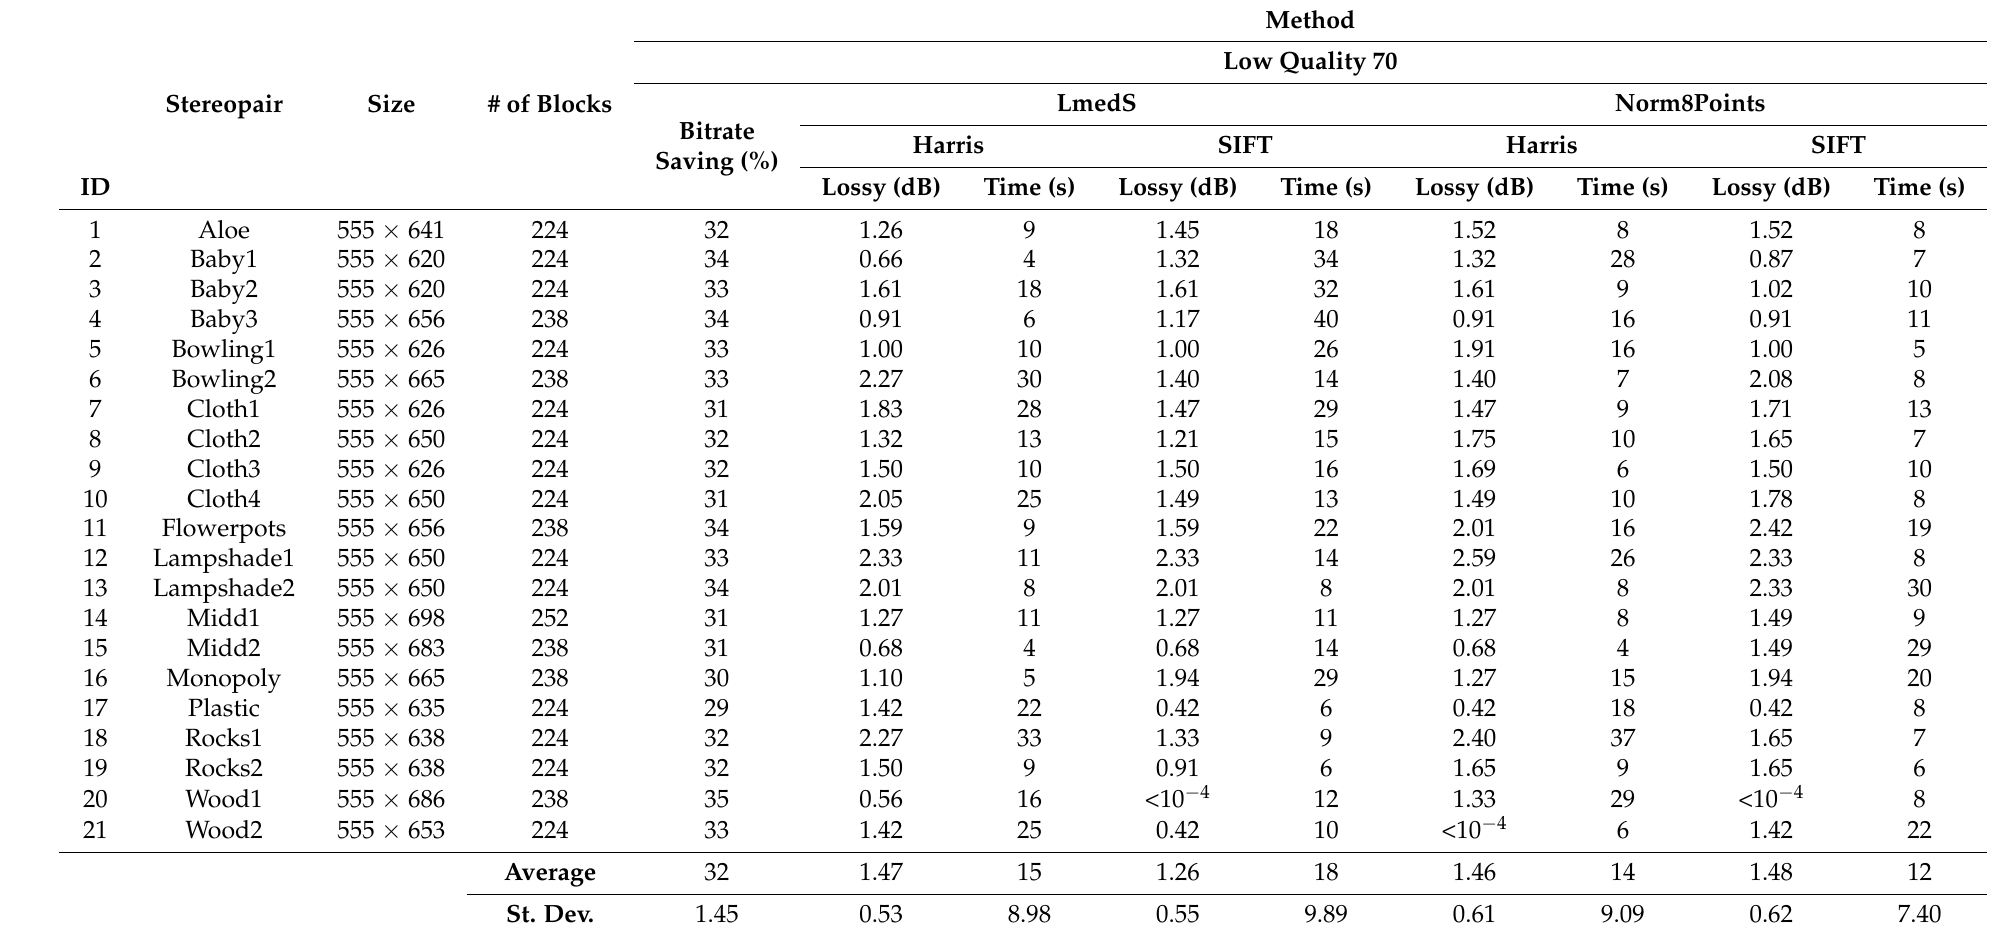
Table 5. Results on the Middlebury-scenes 2006 dataset, considering a low quality of